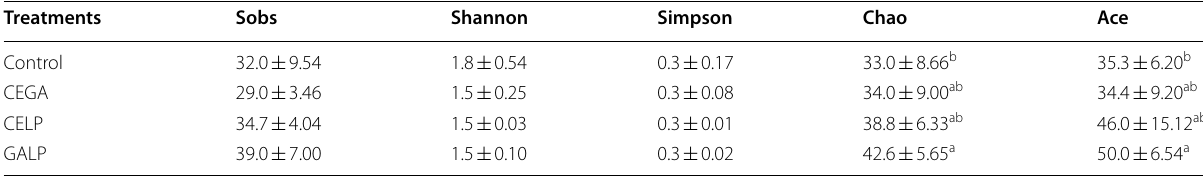
CON untreated silage, CEGA silage treated with cellulase plus ɑ -galactosidase, CELP silage treated with cellulase plus L. plantarum , GALP silage treated with ɑ -galactosidase plus L. plantarum a, b, c Means with different superscripts in the same column differ ( P < 0.05)